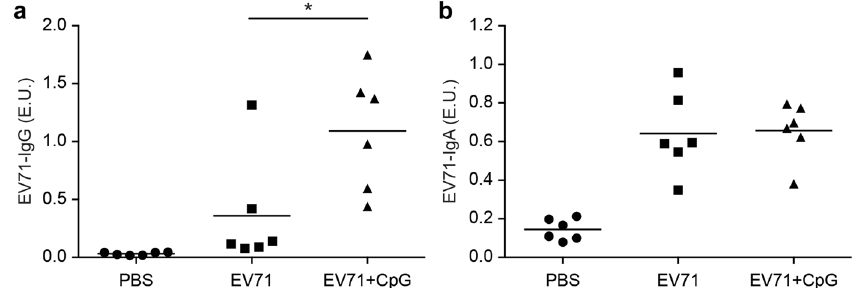
Figure 1. EV71-specific antibody responses measured in serum from BALB/c mice immunised with CpG as an adjuvant for a formalin-inactivated EV71 vaccine. Mice were intranasally immunised with PBS, formalin- inactivated EV71 (5 μ g/dose), or formalin-inactivated EV71 (5 μ g/dose) plus CpG (20 μ g/dose) three times at 3-week intervals. ELISA was used to measure EV71-specific IgG ( a ) and EV71-specific IgA ( b ) in the serum of mice at 2 weeks after the third immunisation. Values shown are means ± SEMs of six mice in each experimental group; * p < 0.05. One representative study of three with similar results is shown. E.U.: ELISA